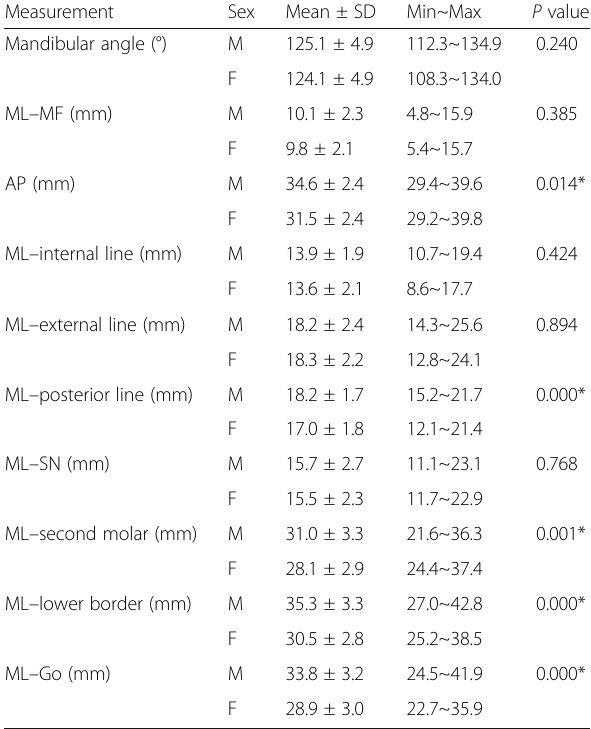
Table 2 Data of measurements on mandibular ramus